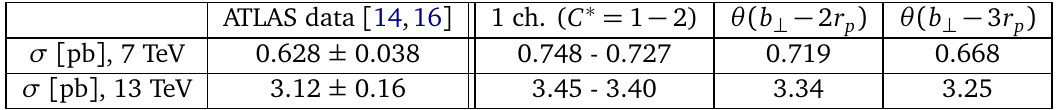
Table 4: Comparison of predictions for exclusive dimuon production in pp collisions, as in Table 2, but considering extreme variations in the modelling of survival effects, as described in the text.